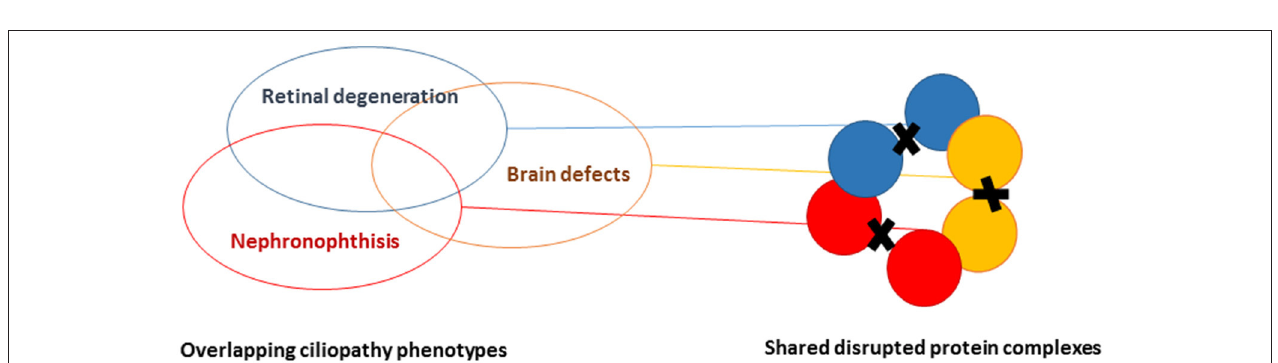
FIGURE 2 | Screenshots from parts of the nephronophthisis database. Numbers indicate the number of fields attributed to a specific theme.